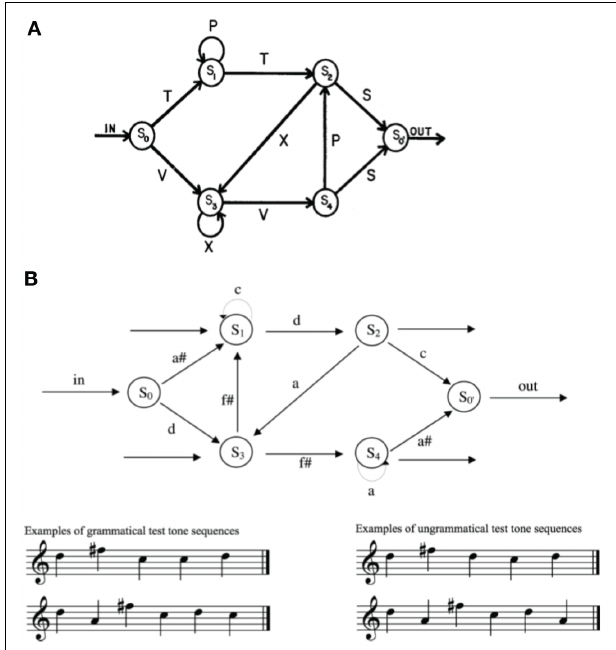
FIGURE 1 | Examples of finite state grammars used in language (A) and music (B) learning experiments. (A) is a finite state grammar used to generate sequences of letters that participants are exposed to in implicit language learning experiments (from Reber, 1967); (B) shows a similar structure, using notes instead of letters (fromTillmann and Poulin-Charronnat, 2010). Participants can acquire grammars of this sort and identify valid versus invalid sequences without being explicitly aware of any specific aspects of the grammar for both music and